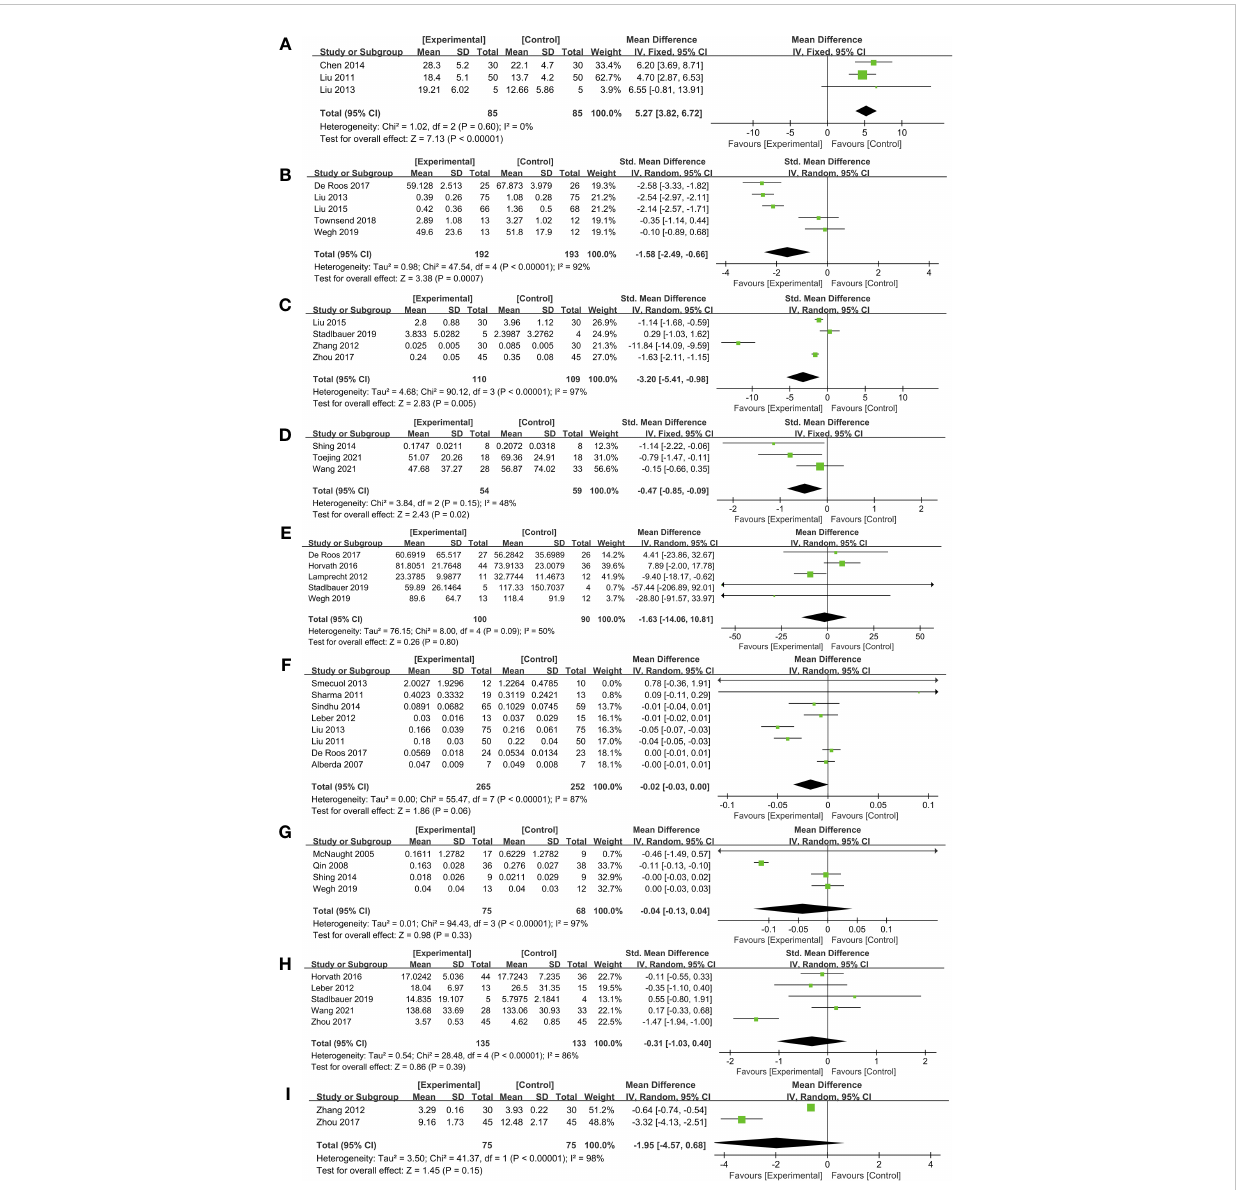
FIGURE 2 Forest plots of the effect of probiotics on intestinal barrier function. (A) TER, (B) Serum zonulin, (C) ET, (D) LPS, (E) Fecal zonulin, (F) L/M, (G) L/R, (H) DAO, (I) D-LA. DAO, diamine oxidase; D-LA, D-lactic acid; ET, endotoxin; LPS, lipopolysaccharide; L/M, lactulose to mannitol; L/R, lactulose to rhamnose.